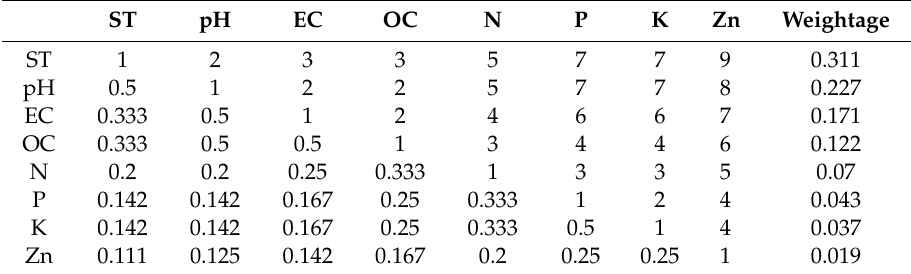
Table 5. Pair wise comparison matrix and eigenvector of criteria in analytical hierarchy process (AHP) for rice crop ( n =